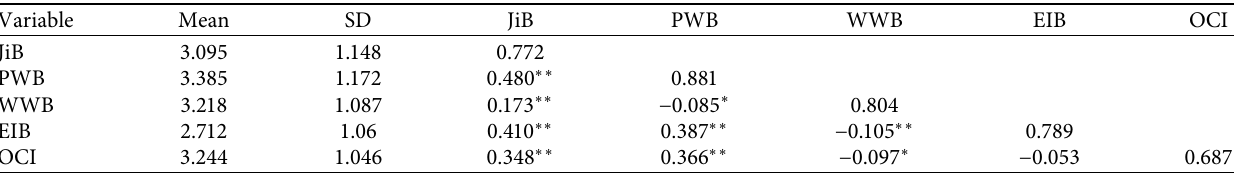
Table 3: Mean, SD, and correlation coefficient matrix.